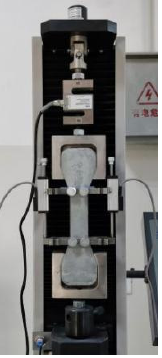
Figure 4. Uniaxial tensile test device.